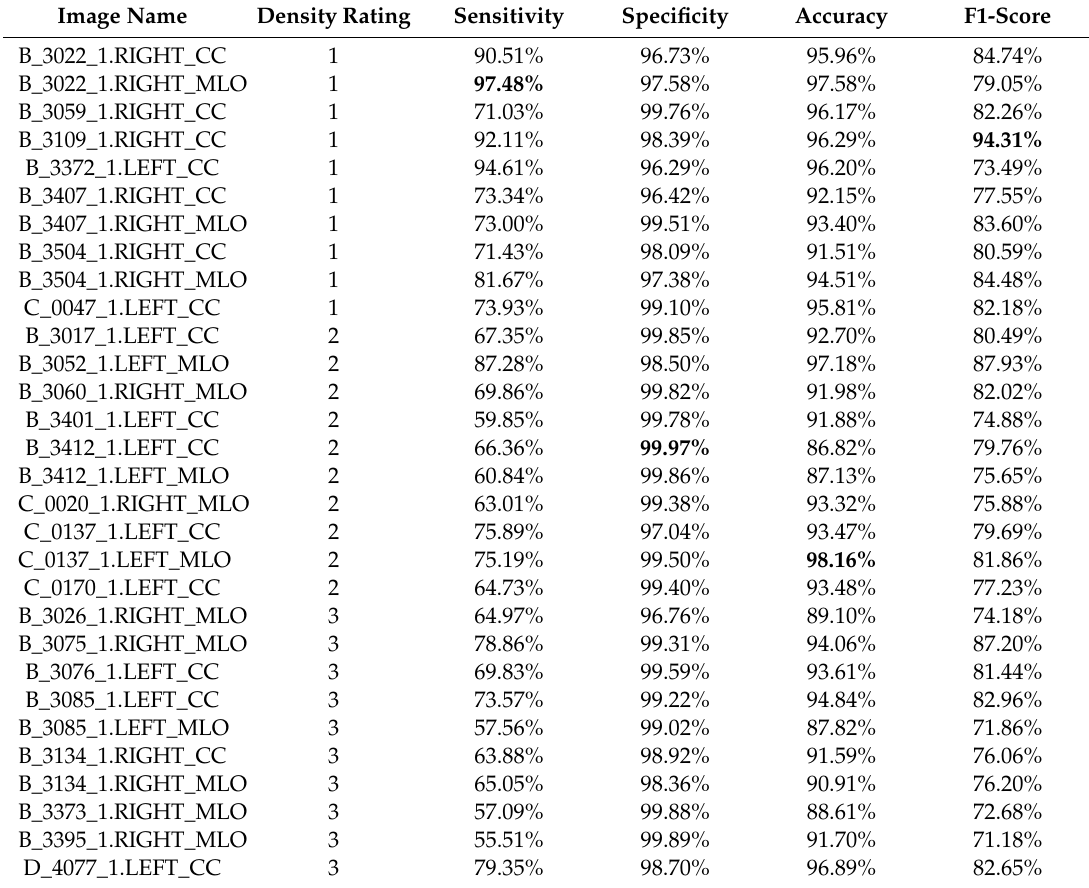
Table 6. Detection results of images of di ff erent density rating.